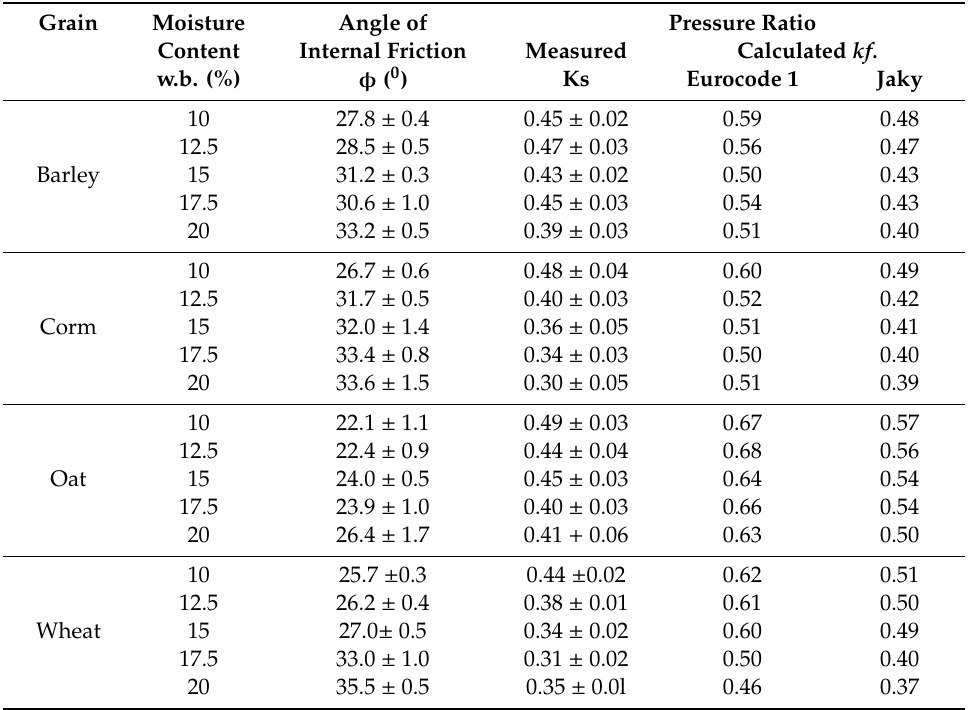
Table 5. Relationship between the bulk grain coe ffi cient of internal friction and the moisture content for oat, corn, and barley